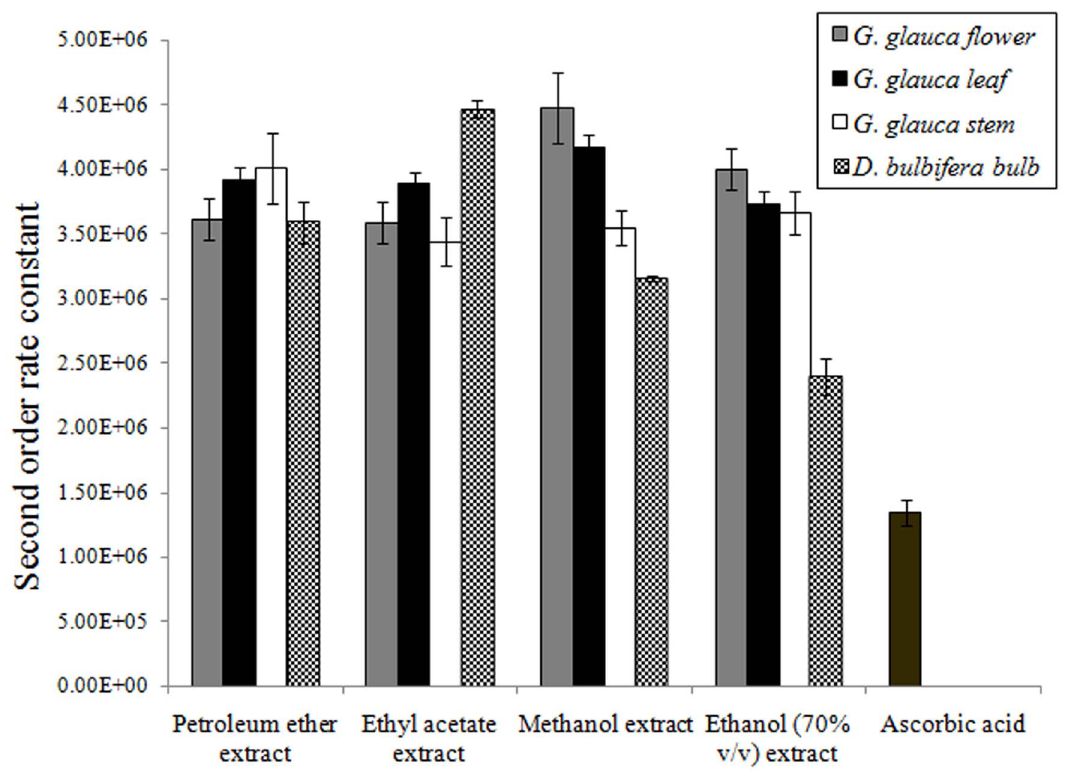
Figure 1. Pulse radiolysis generated OH radical scavenging by plant extracts.